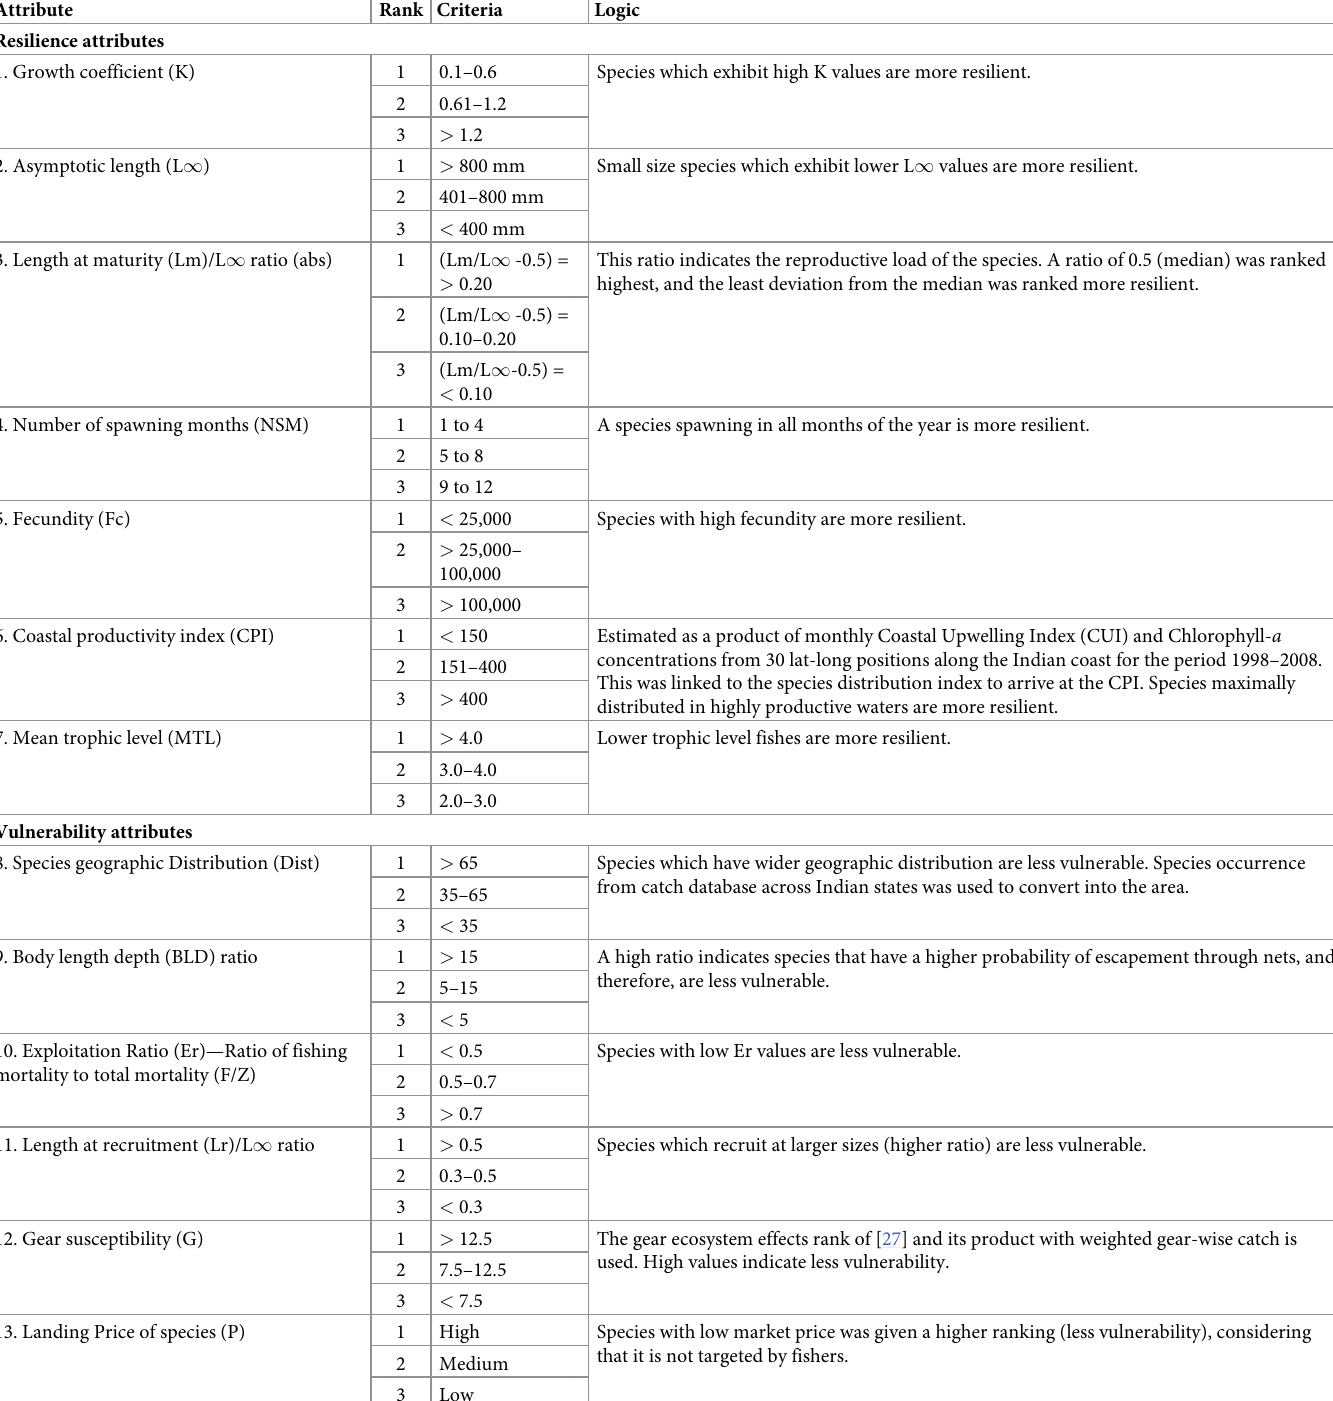
Table 2. Ranking criteria and logic [24,26]of different resilience and vulnerability attributes used in